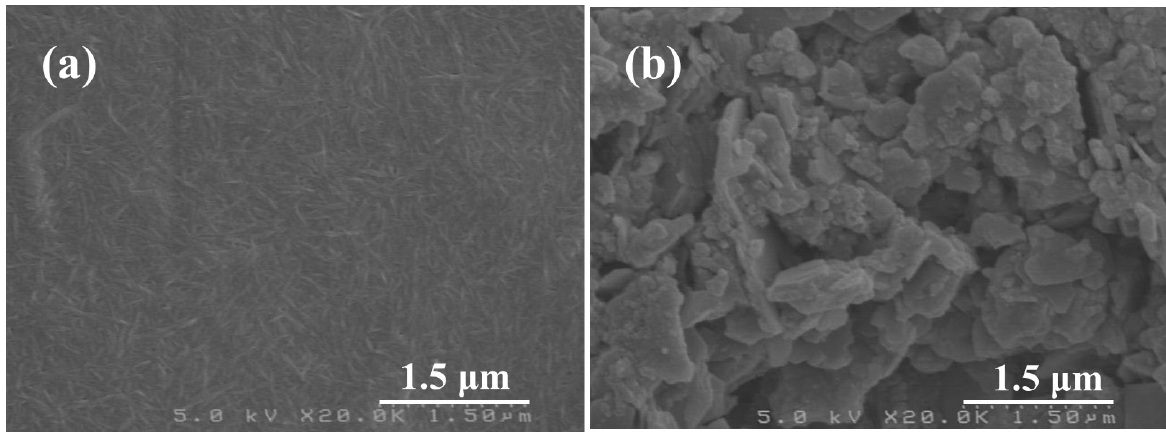
Figure 3. SEM images of ( a ) PDA-ChNF film and ( b ) ChNF film with oligochitin dihexanoate graft chains.